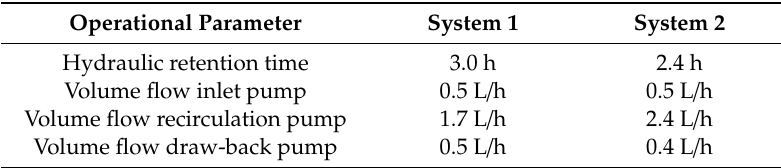
Table 1. Operational parameters of the lab-scale sewage treatment